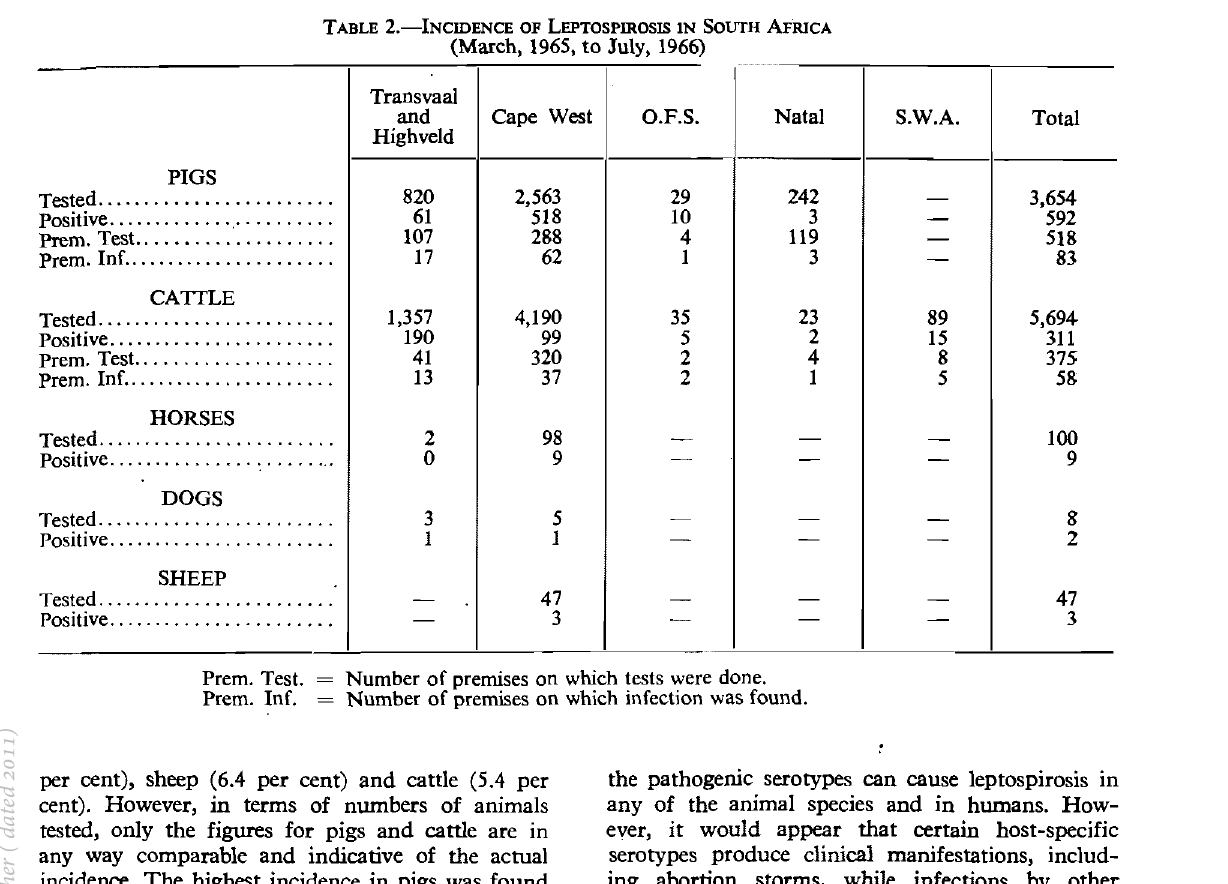
TABLE 2.-INCIDENCE OF LEPTOSPIROSIS IN SOUTH AFRlCA (March, 1965, to July, 1966)